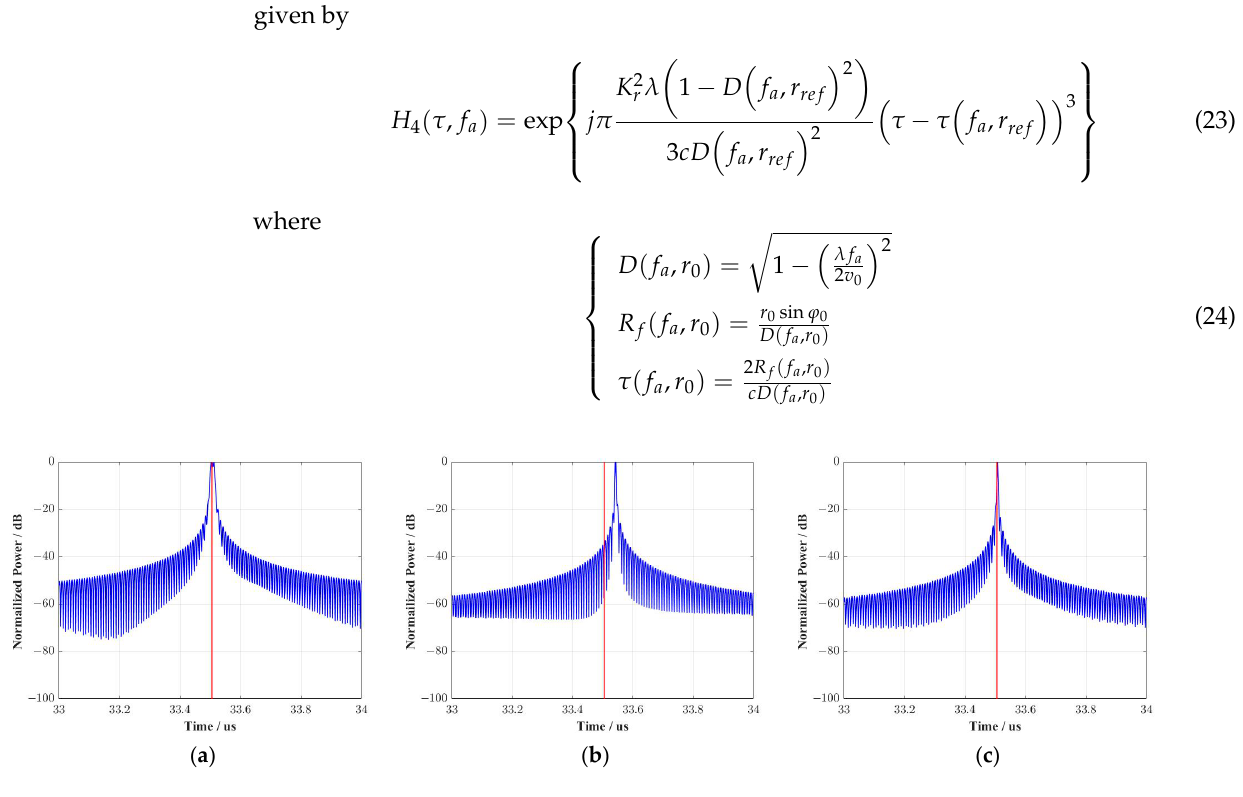
Figure 7. The results of range phase perturbation processing. ( a ) Compression result before range phase perturbation. ( b ) Compression result after range phase perturbation ( c ) Compensation result of range phase perturbation compensation. The red solid line represents the reference position of range compression.